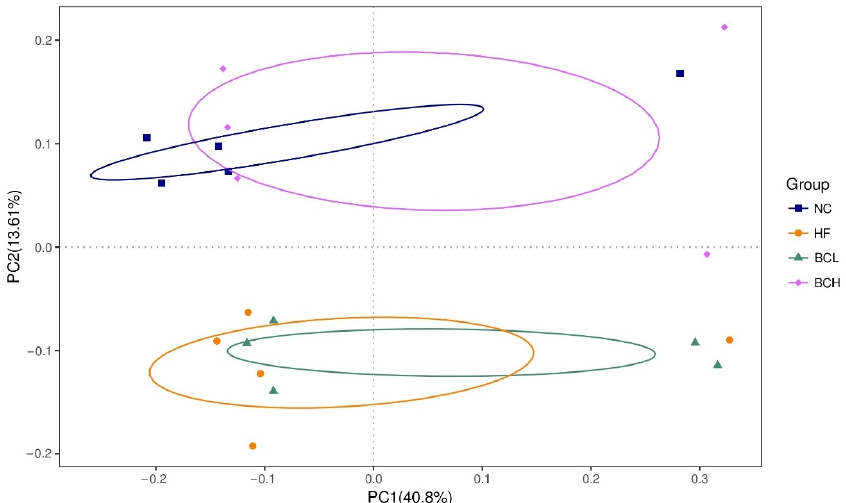
Figure 6. Beta diversity of gut microbiota within rats fed chow diet (NC group), high-fat diet (HF group), high-fat diet + low dose of B. coagulan BACO-17 (7 log CFU/day) (BCL group), and high-fat diet + high dose of B. coagulan BACO-17 (9 log CFU/day) (BCH group) ( n = 5 per group). Principal coordinate analysis (PCoA) plotted for the measurement of similarity of microbial community among all groups.